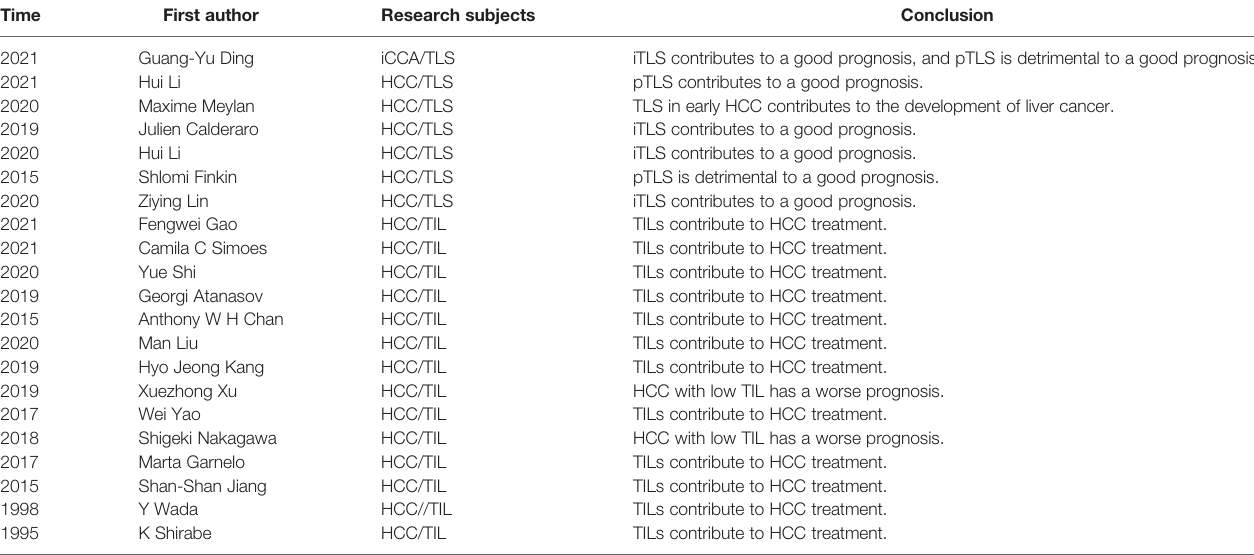
TABLE 1 | Recent research on TLS in